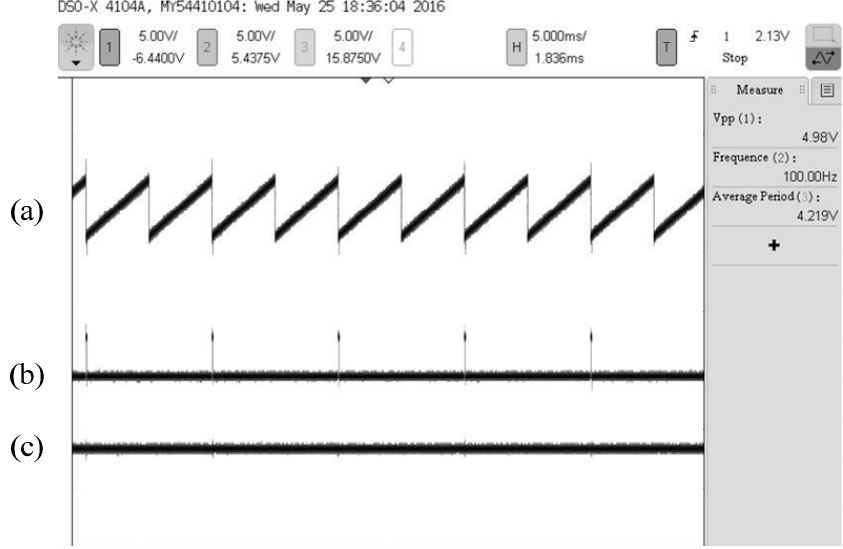
Figure 8. Oscillogram of the sensor output signal with a simulative rotational speed of 100 rps: ( a ) Angular displacement information; ( b ) The refresh pulse; ( c ) Angular velocity information.